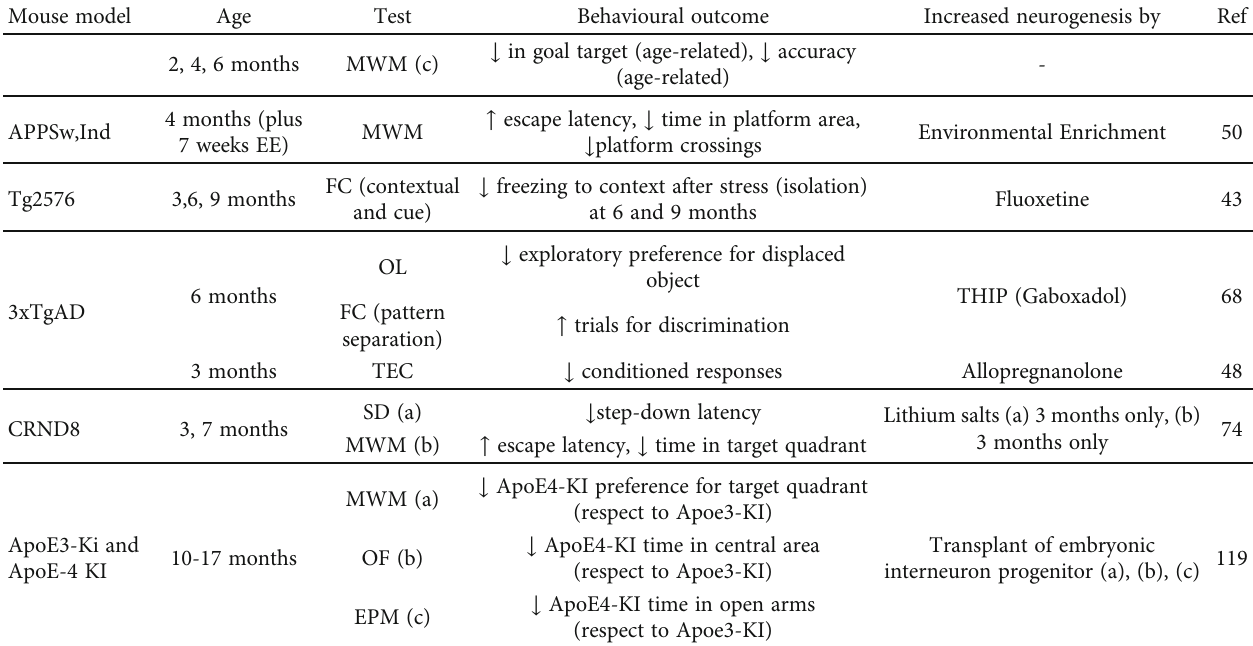
Table summarizes studies investigating neurogenesis and memory in distinct AD mouse models (column 1) at di ff erent age points (column 2). Column 3 reports the memory test(s) used in each study. Column 4 refers to results from each memory test with symbols indicating increase ( ↑ ), decrease ( ↓ ), or no variation (=) of speci fi c behavioral outcomes as compared to wild type controls (unless otherwise indicated). Please note ( ↑ ) latency corresponds to lower memory. When available, treatments that were associated with a rescue in neurogenesis and also ameliorated memory are reported in column 5. MWM: Morris water maze (standard or radial); PA: passive avoidance; SD: step down; FC: fear conditioning (contextual or cue); EPM: elevated plus maze; NOR: novel object recognition; OF: open fi eld; YM: Y maze; SA: spontaneous alternation; OL: object location; TEC: trace eye-blink